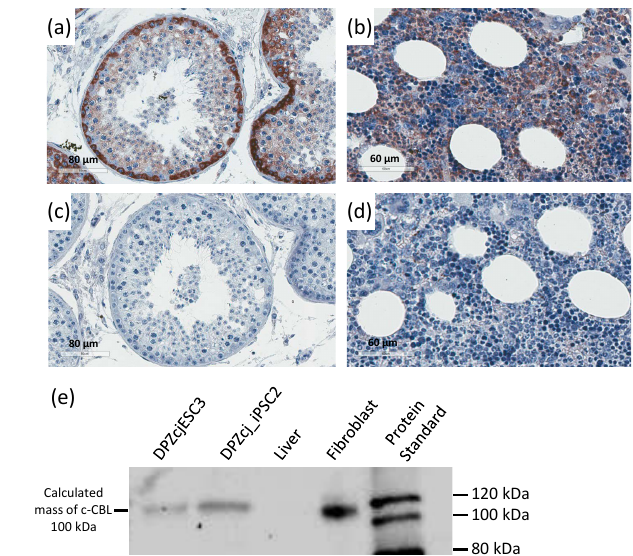
Figure 1. Validation of the c-CBL antibody for the marmoset. (a) Immunohistochemical localization of c-CBL in the marmoset testis. (b) Immunohistochemical localization of c-CBL in mar- moset bone marrow. (c) and (d) show IgG controls corresponding to (a) and (b) . (e) Non-quantitative western blot of protein lysates from ESCs (DPZcjESC3), iPSCs (DPZcj_iPSC2), liver and skin fibroblasts to ensure the detection of a protein of the expected size also in marmoset samples. Only one band of the apparent size of ∼ 110kDa is visible in the stem cell samples and fibroblasts. The calculated size of c-CBL is 100.67kDa. The data indicate specific binding of the antibody also to marmoset c-CBL.